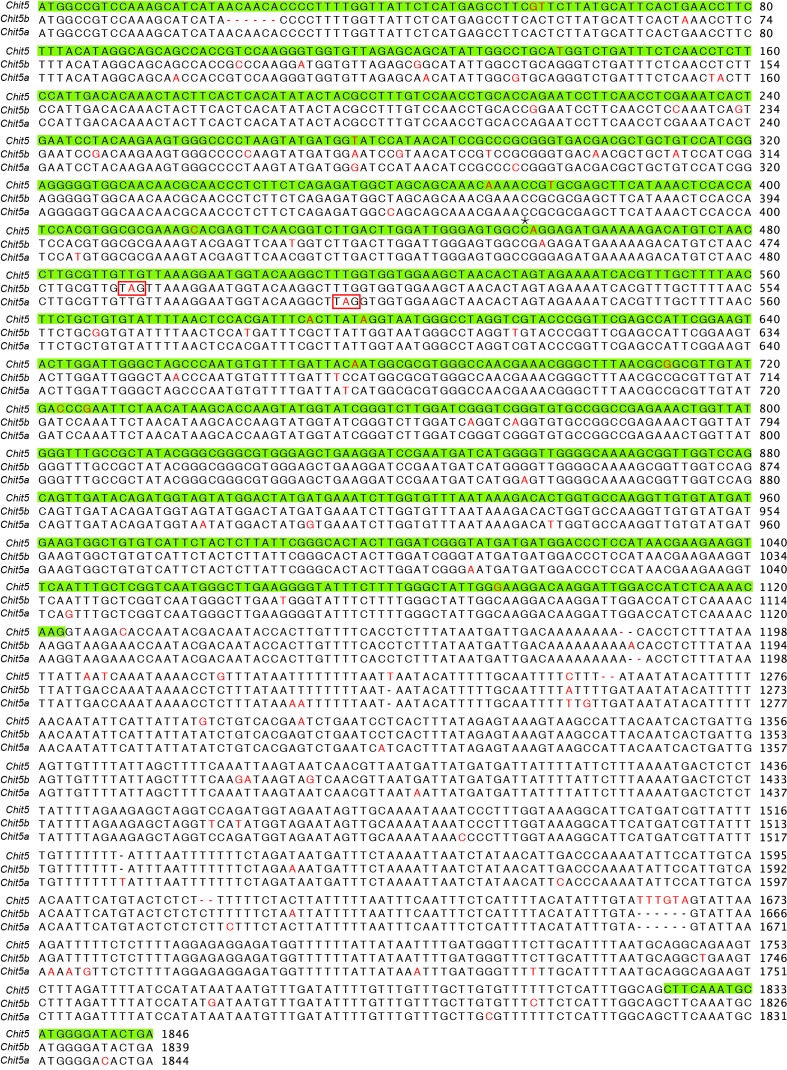
Alignment of Chit5 paralogs.Nucleotide sequence alignment of Chit5 and its two paralogs (start to stop codons). Exons are highlighted in green and nucleotide polymorphisms are shown in red. The premature stop codons in the paralogs are highlighted by red boxes and the position of the C to T point mutation in chit5-2 is indicated with an asterisk.